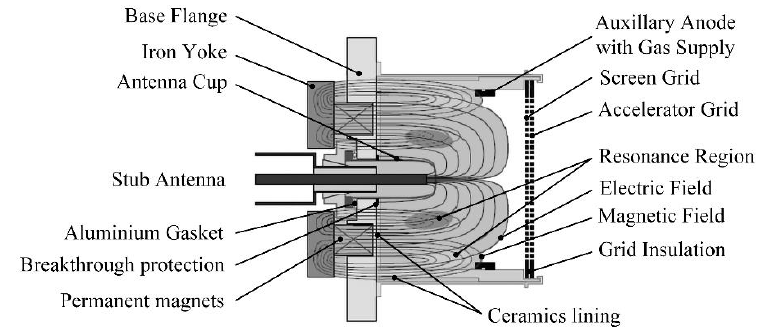
Figure 1. Schematic diagram of microwave cyclotron resonance ion source.